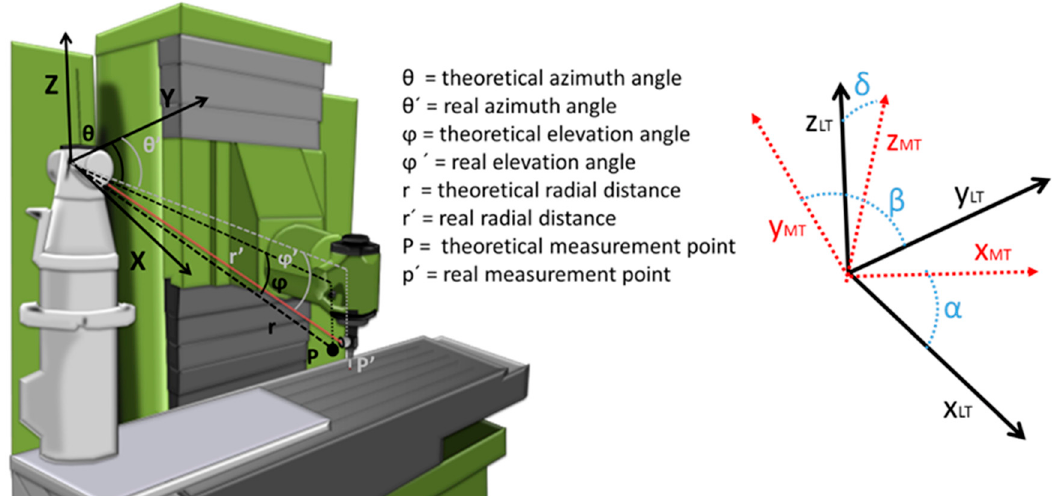
Figure 4. LT measurement uncertainty and location parameters.